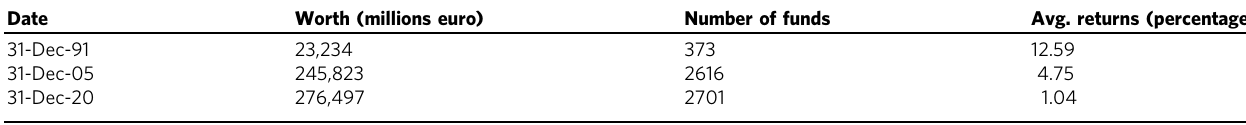
Table 1 Spanish investment funds simpli fi ed